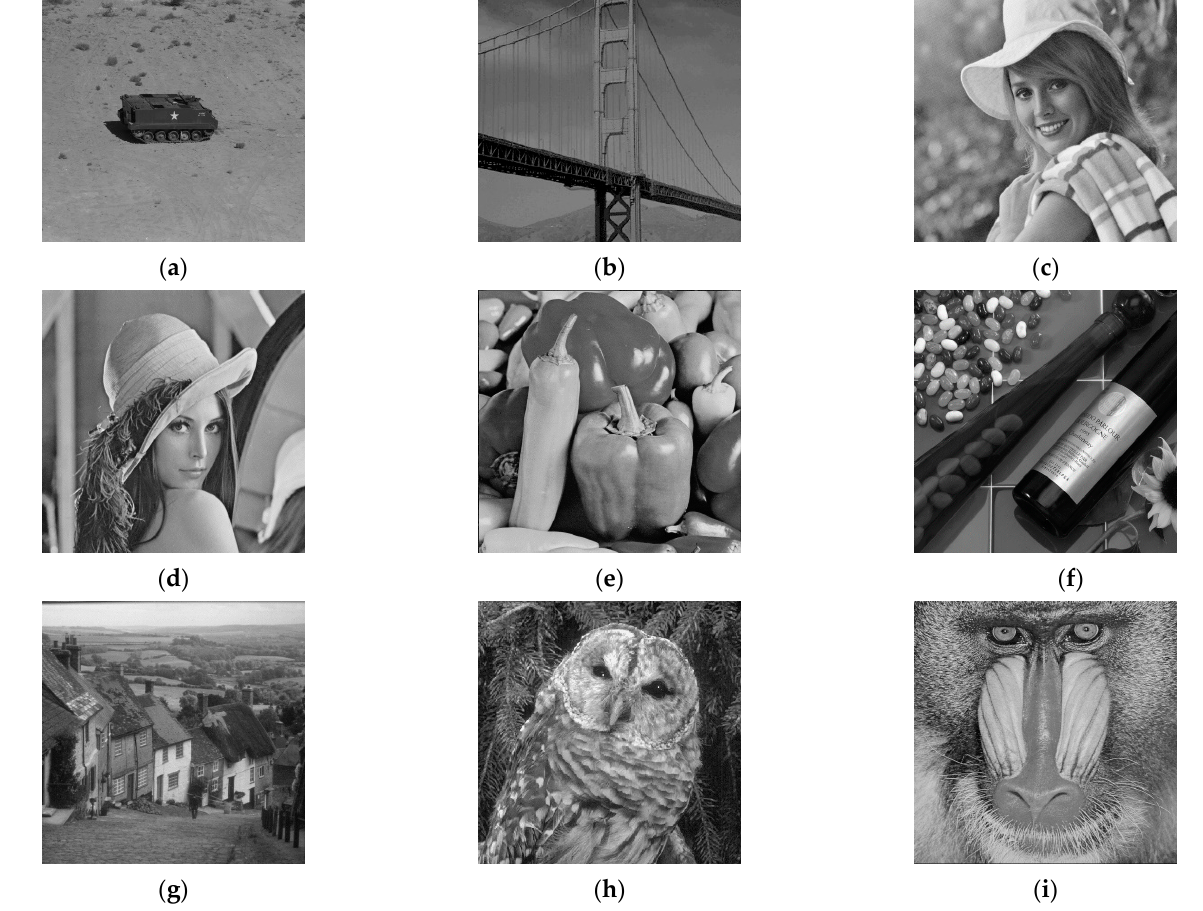
Figure 18. Nine standard grayscale test images applied in our experiment. Tank ( a ), Bridge ( b ), Elaine ( c ), Lena ( d ), Peppers ( e ), Wine ( f ), Goldhill ( g ), Bird ( h ), Baboon ( i ).